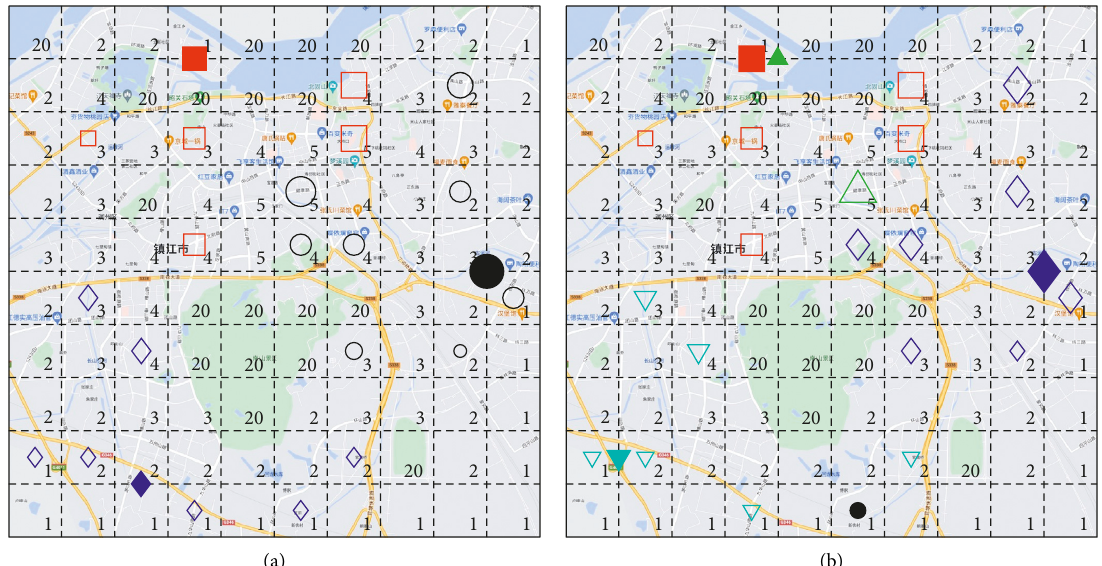
Figure 8: Location and allocation plan of ABC using RPK (a) and TES (b) encoding